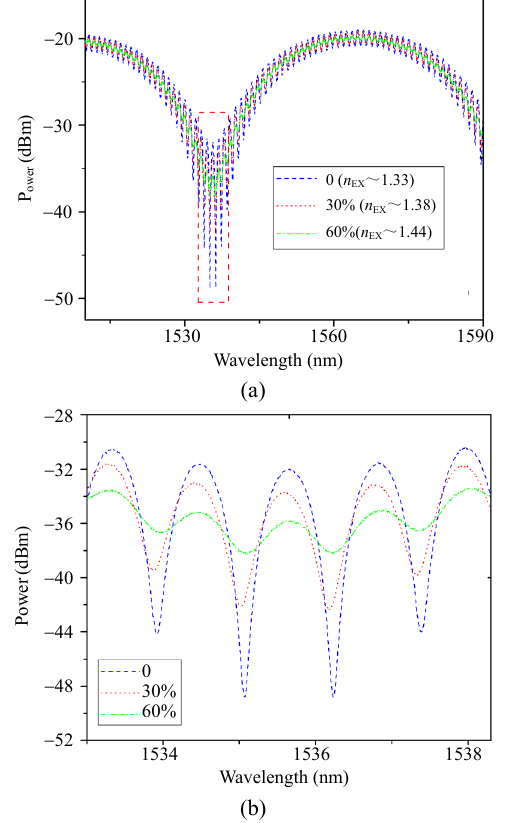
Fig. 5 Experimental results: (a) interference spectra of the FPI in solutions with different concentrations corresponding to different RI (0, 30% and 60%) and (b) close-up display.